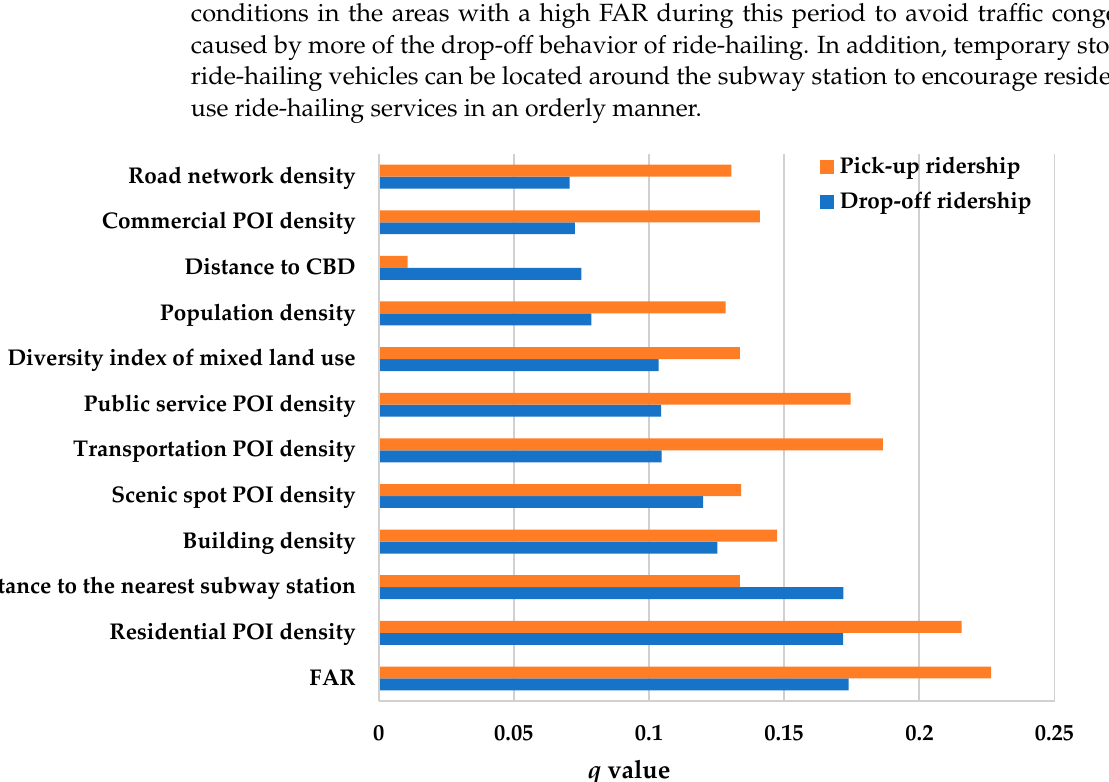
Figure 9. Contribution of single explanatory variables on pick-up and drop-off ridership in the even- ing peak hours by the factor detector. The FAR, residential POI density, and distance to the nearest subway station are the major contributors to the pick-up ridership in the evening peak hours, with contributions